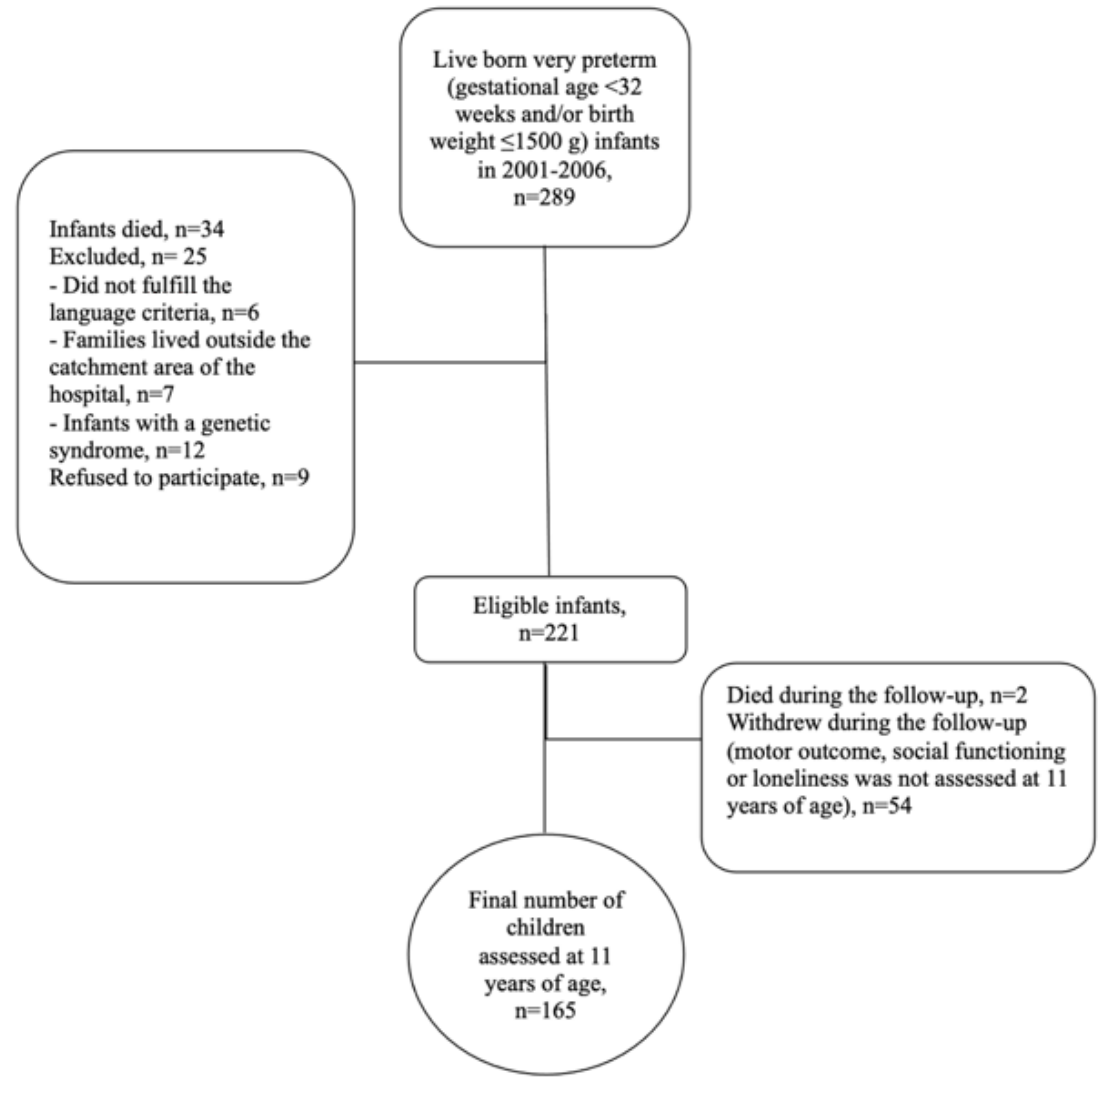
Figure 1. Flowchart of the